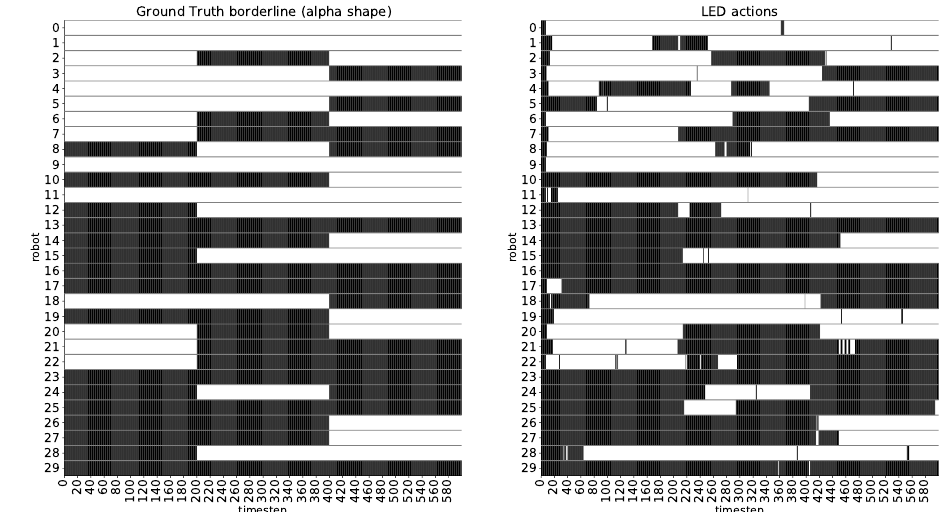
Figure 14. ( Left ) Target frontier members (according to alpha shape). Black bars indicate that the robot is in the alpha shape and blank bars represent interior nodes. ( Right ) Robots LED actions. The swarm topology is switched to a different one (randomly sampled) every 200 time steps.